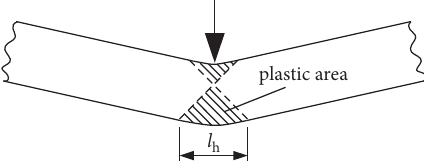
Figure 2: Plastic area at the impact point of a rectangular cross- section